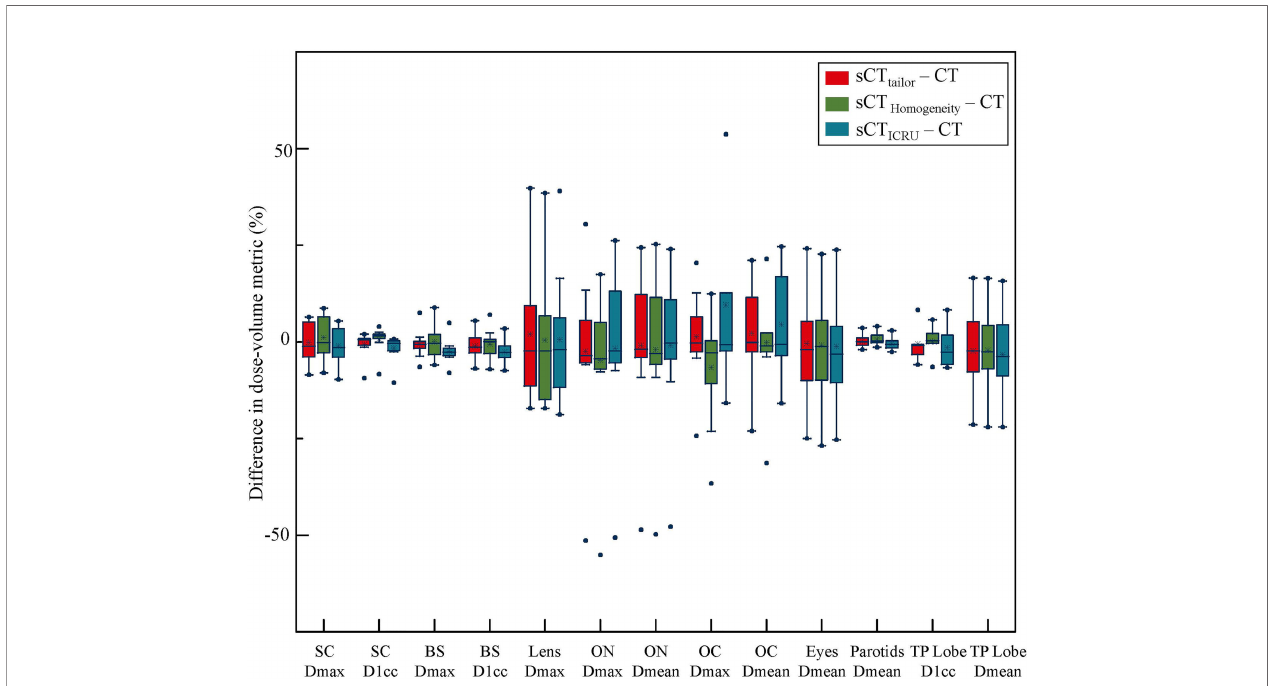
FIGURE 3 | Box-plot analysis related to the dose differences of sCT tailor , sCT ICRU , and sCT Homogeneity with respect to the original CT for different DVH parameters related to OAR sparing. The dot marks the outlying